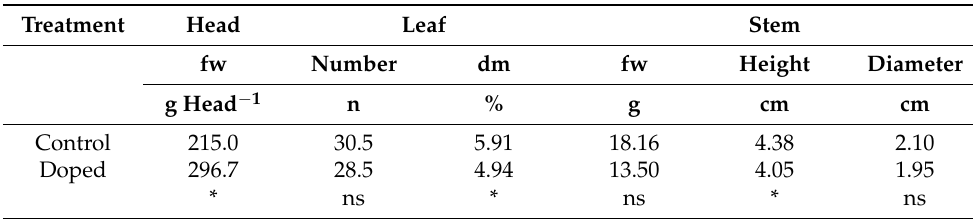
Table 1. Lettuce growth parameters (head fresh weight (fw), number and mean weight of leaf, leaves dry matter (dm), and fresh weight, height and diameter of stem). Treatment Head Leaf Stem fw Number dm fw Height Diameter g Head − 1 n % g cm cm Control 215.0